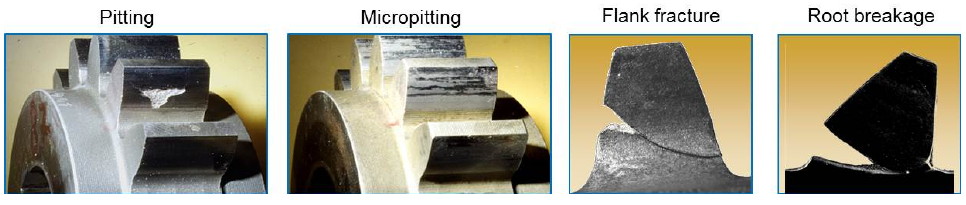
Figure 3. Main gear fatigue failure modes.